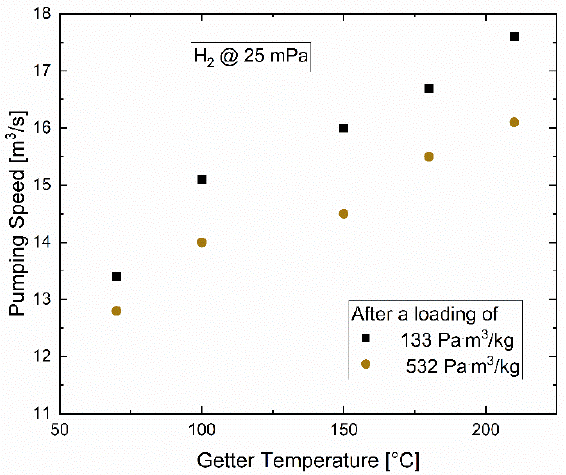
Figure 12. Comparison of the pumping speed results depending on the getter temperature during sorption for low and moderate inventories.